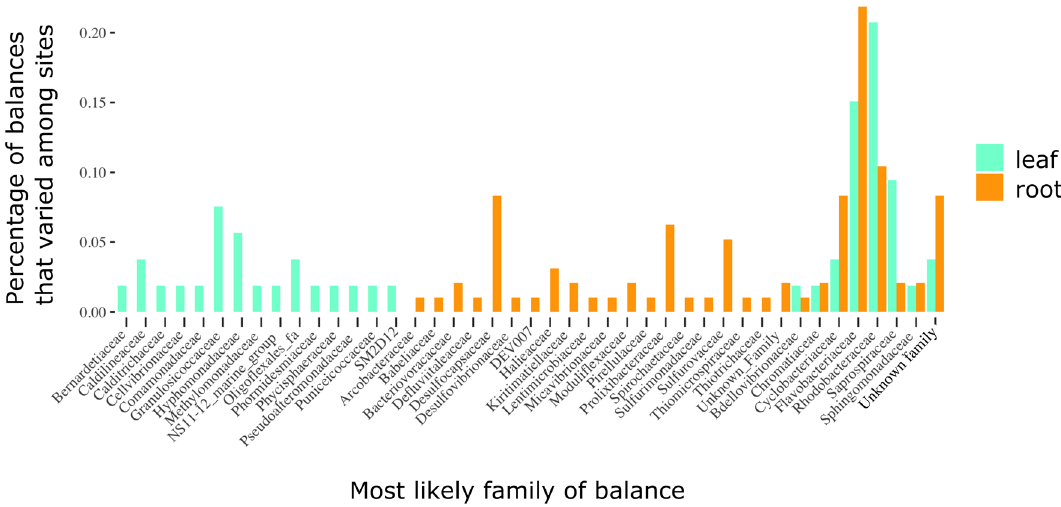
Figure 6. Microbial families contributing to differences among sites for both eelgrass leaves (teal) and roots (orange) based on identity of significant node (see Supplemental Information on balances and Supplemental Figs. S2–S7 for more details on these balance identities). We then compared families that varied in leaves among sites to those among roots below. A few families that varied among sites in both compartments, but most families that varied among sites were specific to leaves or roots (Fisher’s Exact Test p <